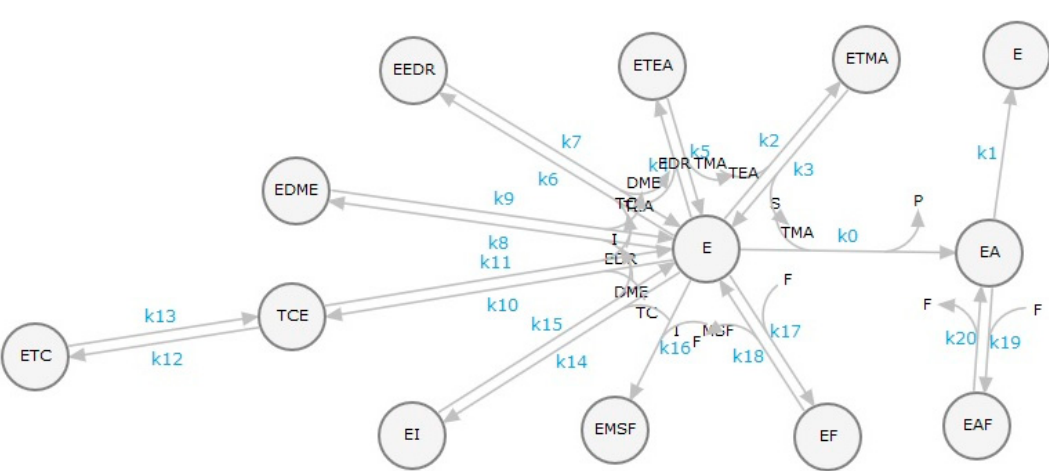
Figure 2. Reaction scheme for the simultaneous analysis of four competitive reversible enzyme inhibitors: a mixed reversible enzyme inhibitor, an irreversible inhibitor, a slow binding inhibitor, and a tight binding reversible inhibitor in the presence of the substrate. In this scheme, E is horse BChE, the reversible inhibitors are tetramethylammonium(TMA), tetraethylammonium (TEA), edrophonium (EDR), and decamethonium (DME), the mixed inhibitor is sodium fluoride (F), the slow binding inhibitor is d -tubocurarine (TC), which acts in two steps, as an instantaneous step followed by a slow isomerization, the irreversible inhibitor is methanesulfonylfluoride (MSF), and the tight binderis 942 (I). S represents the substrate BSCh and P represents thiocholine, a detection product. k 0 –k 20 are second and first order rate constants. The scheme was generated by the web application ENZO at http://enzo.cmm.ki.si/kinetic.php?uwd=170623269&load=true. SodiumFluoride as an Inhibitor of Butyrylthiocholine Iodide Hydrolysis by Horse